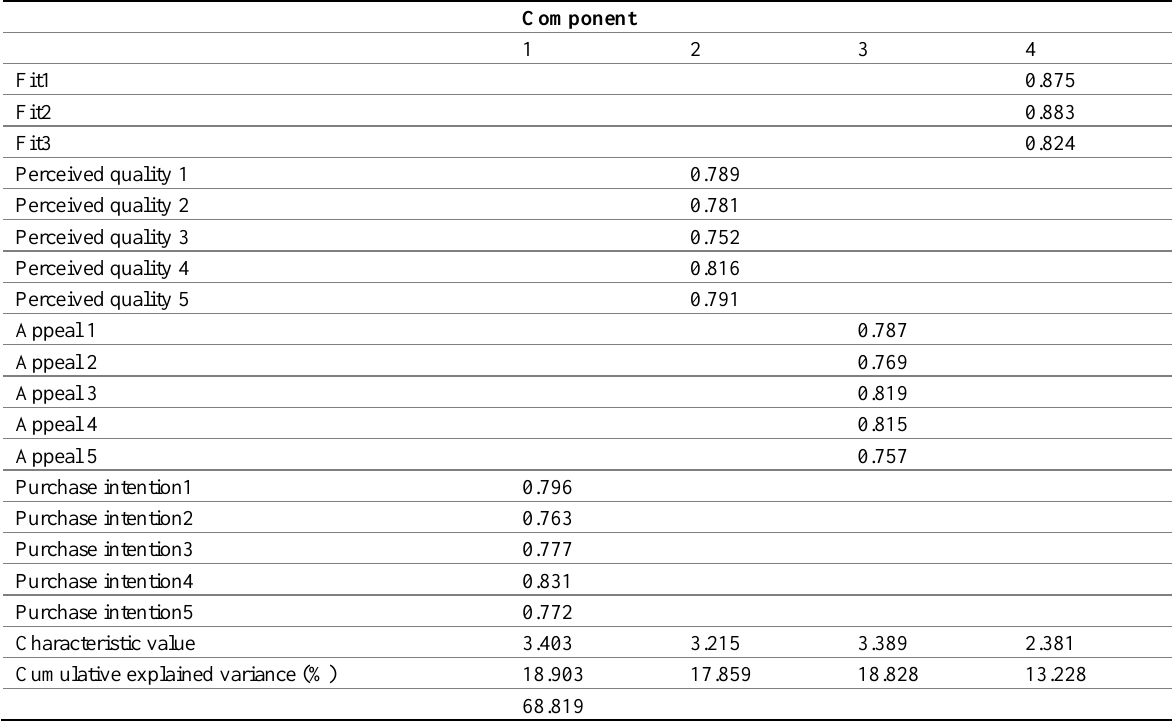
Table 5: Rotated component matrix